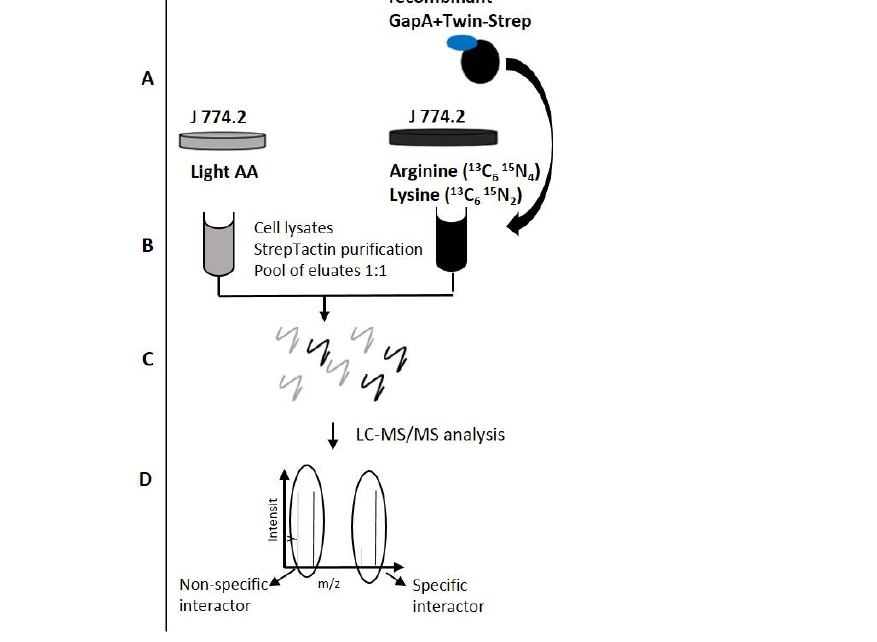
Figure 4. Schematic overview of the interaction partner screen. Cells were grown in medium with light or heavy amino acids (arginine 13 C 6 15 N 4 ; lysine 13 C 6 15 N 2 ) and lysed (A). Heavy-labeled cell lysate was incubated with purified Twin-Strep tagged GapA and these “heavy” lysates, as well as control “light” lysates, were subjected to purification using StrepTactin (B). The eluates were pooled, digested with trypsin (C), then analyzed by LC-MS/MS and evaluated (D). Based on the evaluation criteria described in the Materials and Methods section, seven potential GapA binding partners were identified in this screen (Table 1): three tu- bulin subunits, one ribosomal protein, one protein of translation initiation complex (eIF4H), and two multifunctional proteins (DDX3X and S100A6) involved in multiple cel- lular processes. The interaction of eukaryotic GAPDH with tubulin is generally known and has been described in a number of studies (reviewed in [1]). The exact role of GAPDH in this interaction remains unknown. One study indicated that protein might be involved through an interaction with tubulin in the modulation of membrane trafficking and mem- brane fusion [38]. Table 1. Candidate GapA interaction partners identified by SILAC–Pull-Down–MS/MS strategy. Accession Number (Uniprot)